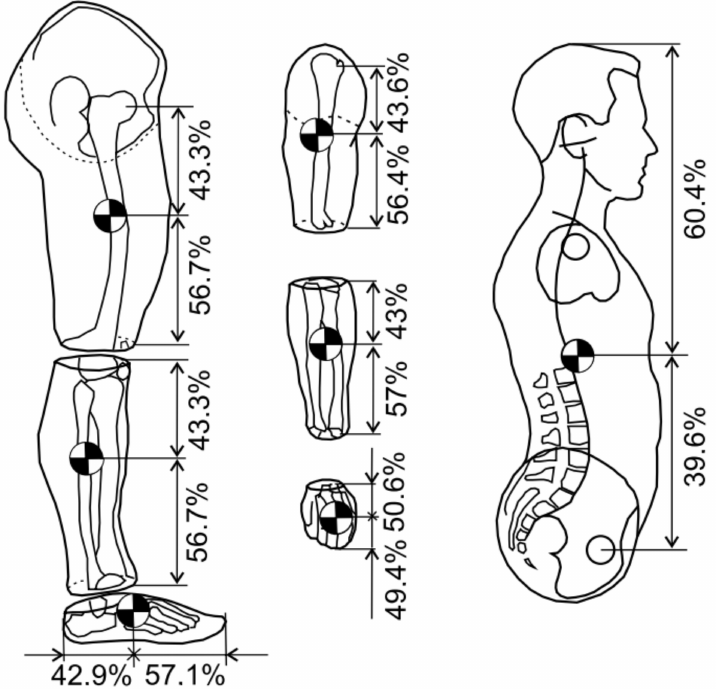
Figure 7. Location of the centres of gravity of individual segments of the human